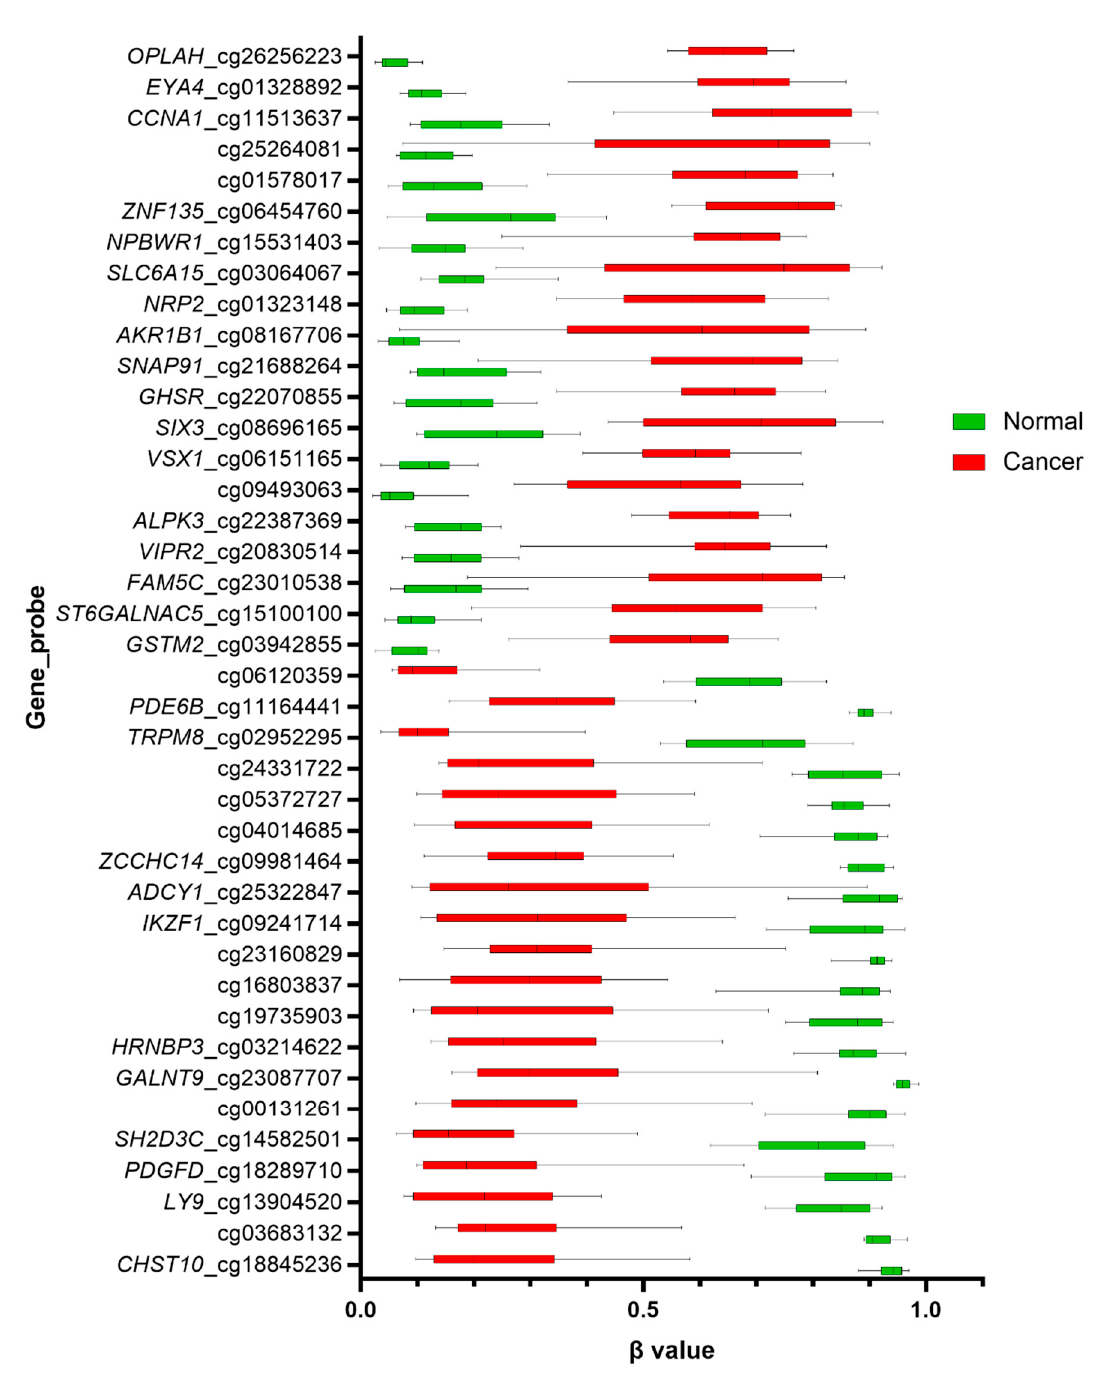
Figure 3. Box plot illustrating the comparison of β values for open chromatin probes in cancerous and normal tissues. The red boxes represent the methylation level in the cancer tissues, while the green boxes represent the methylation level in normal tissue. The top and bottom hinges of the box represent the highest and lowest values, while the thick horizontal lines within the box represent the mean β values.